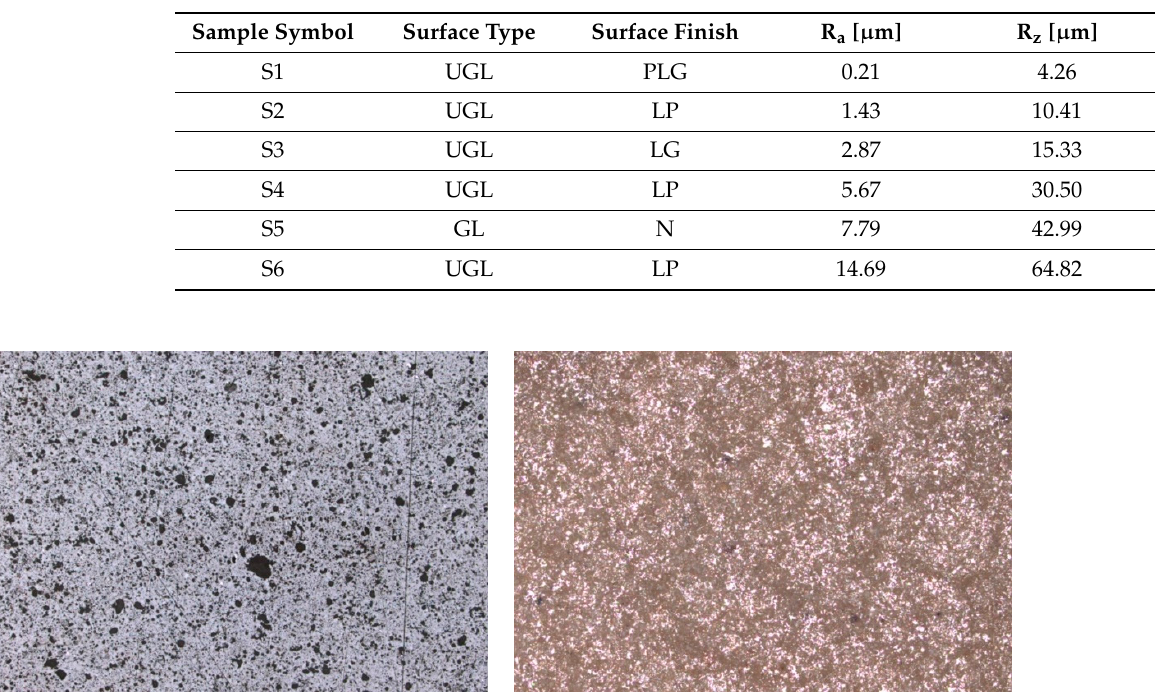
Table 1. The properties of tested ceramic tiles.